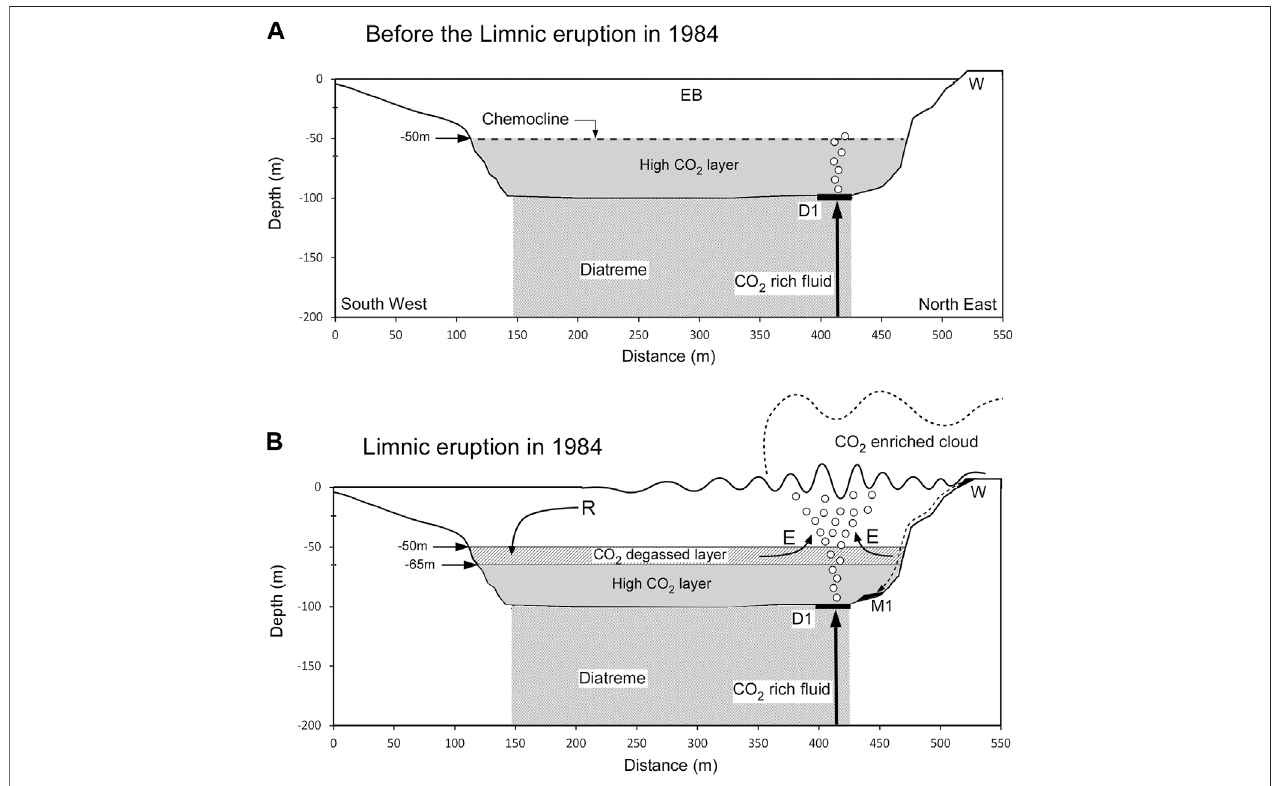
FIGURE 9 | Estimated structure beneath Lake Monoun and the situation of limnic eruption. (A) Presumed situation in EB of Lake Monoun before the 1984 limnic eruption.TheshapeofthebasincorrespondstothecrosssectionalonglineL6in Figure2 .Thelakewaterat − 50 mdepthwasassumedtobesaturatedwithrespectto CO 2aq , based on the CO 2aq pro fi le in 2003 (Kusakabe et al., 2008). The layer below − 50 m depth was undersaturated with respect to CO 2aq . A CO 2 -rich fl uid was transported along the diatreme ring fault and discharged at the bottom of D1. The discharged water at the bottom of D1 was accompanied by bubbles. The bubbles would rise to the chemocline developed at − 50 m depth. (B) Presumed situation of the 1984 limnic eruption. E: entrainment of high-CO 2aq lake water into the ascendingturbulent fl owofCO 2 bubbles,whichampli fi edtheCO 2 fl uxatthelakesurface.W:eastshoreofLakeMonounimpactedbythewavesgeneratedbythelimnic eruption. A landslide started at W, and the mound M1 was deposited beside D1. R: return fl ow depleted in CO 2aq , which invaded the high-CO 2aq layer above − 65 m depth, which was the depth of the [CO 2aq ] chemocline in 1986 (Figure 5F)